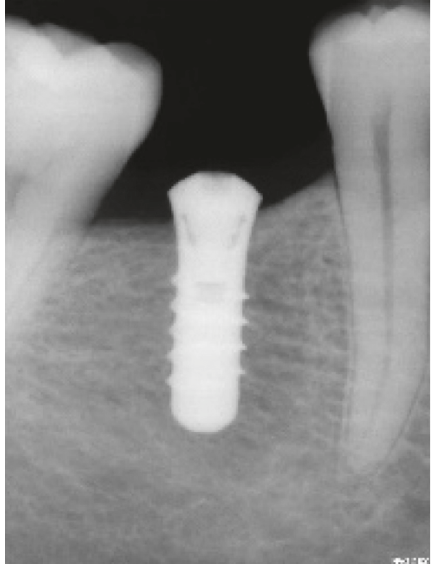
Figure 6: Straumann (4.1 × 10) replacing tooth